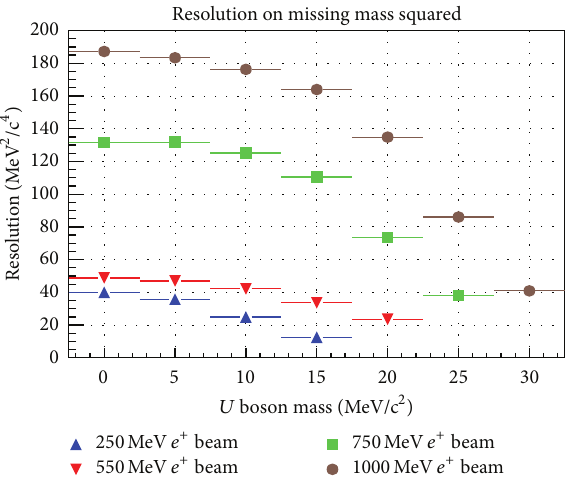
Figure 12: GEANT4 model of the EM calorimeter.